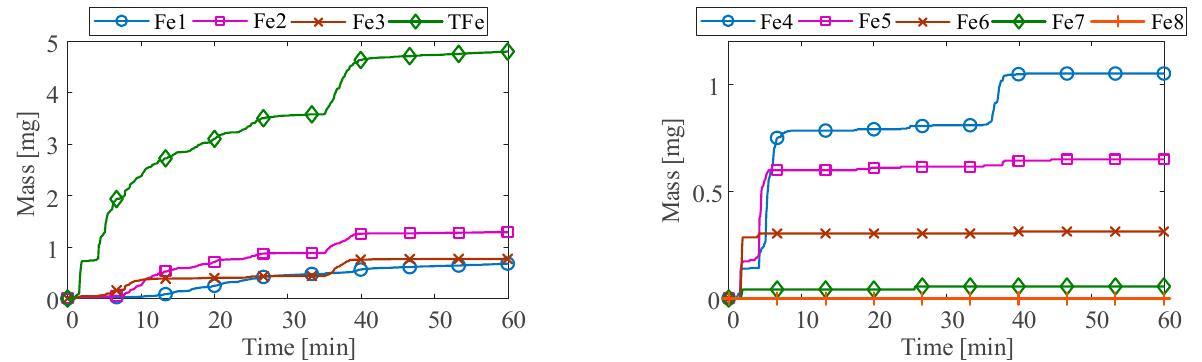
Figure 12. Ferrous particle accumulated mass at abrasive wear.